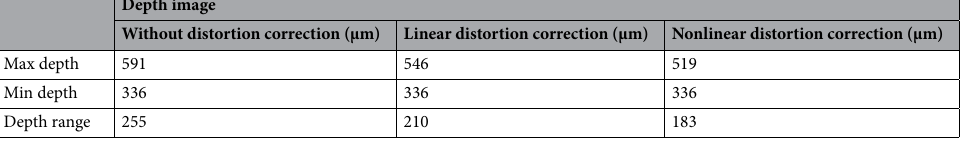
Table 1. Comparison of the depth range of the